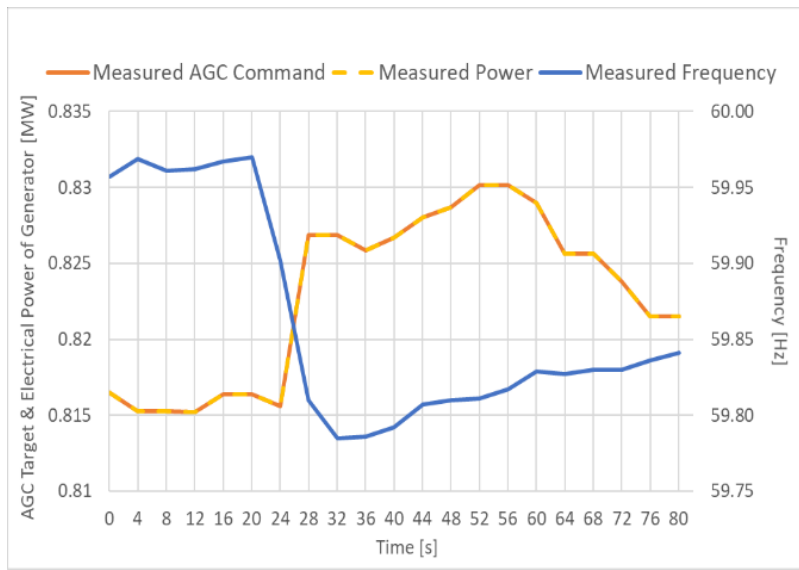
Figure 16. Comparison of the measured and the simulated ACE.